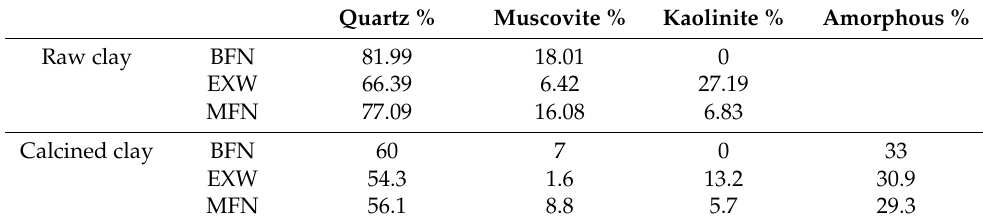
Table 5. Mineral compositions of the clay samples.